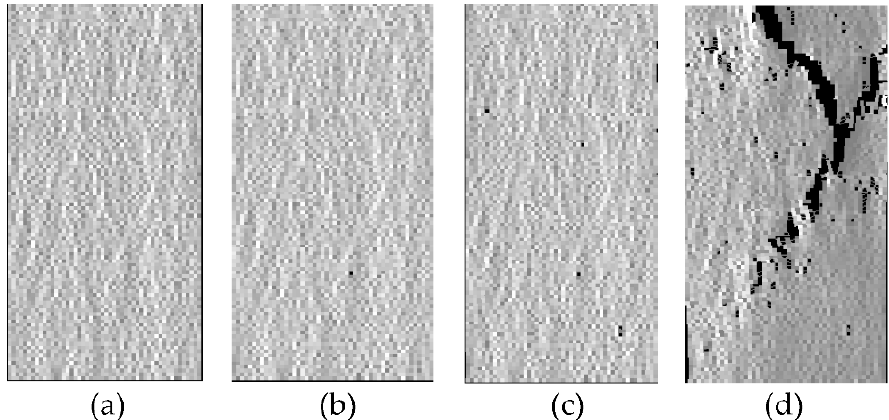
Figure 12. Deformation and rupture of coal samples when the gas pressure is 2 MPa: ( a ) the loading step is 17; ( b ) the loading step is 36; ( c ) the loading step is 50; ( d ) the loading step is 58.